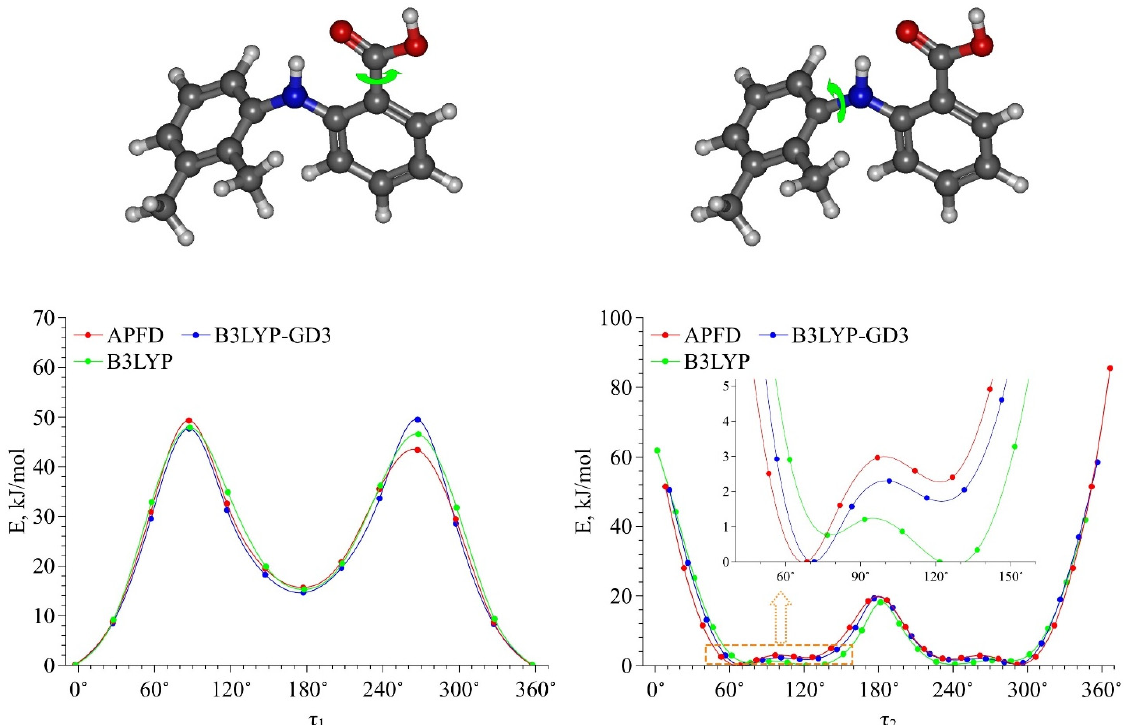
Figure 3. Energy barriers of conformational transitions related to variations of the dihedral angles τ 1 and τ 2 determined using three functionals. The insert on the plot of the energy profile of conformational transition related to variations of the dihedral τ 2 angle shows the difference in the energy profiles in the angle range of 60°–140°.